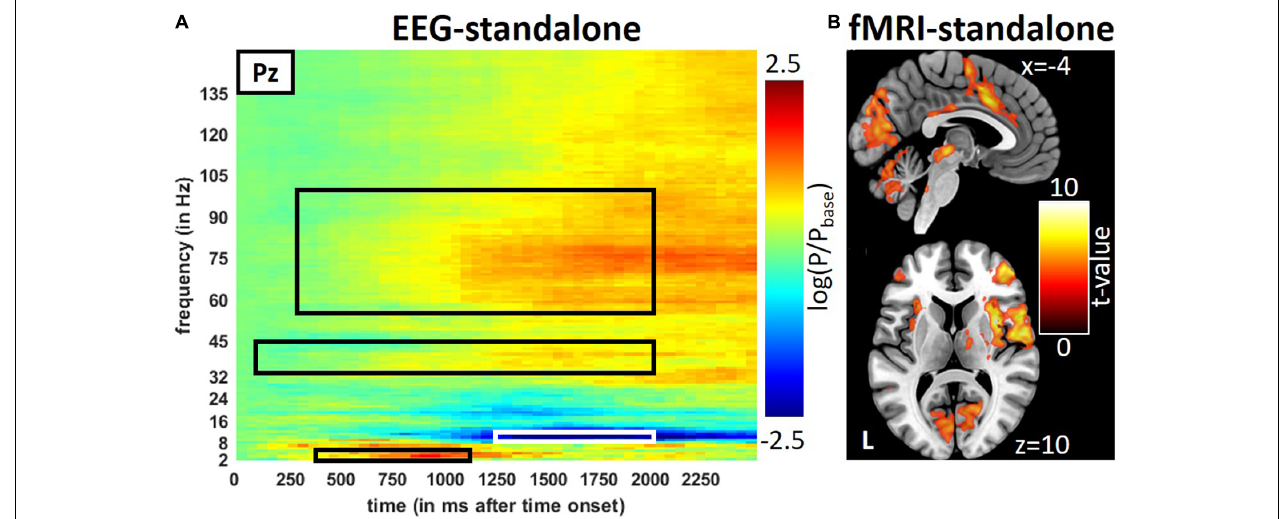
FIGURE 2 | Result from the stand-alone measurements during trigeminal nociception in EEG and fMRI. (A) Averages of stimulus induce power changes in time-frequency bands of trigeminal nociception in the EEG and (B) activity seen by the fMRI. Results of the fMRI are presented at a visualization threshold of p < 0.001 (uncorrected). Time-frequency windows of interest are framed in black or white.